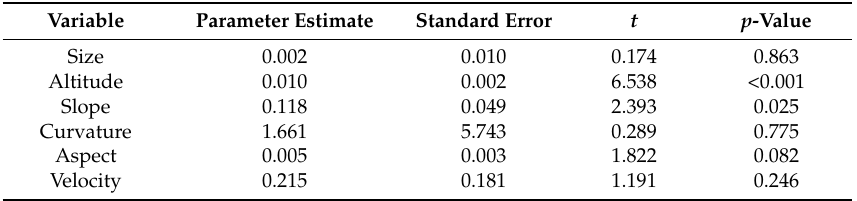
Table 2. Summary of the MLR analysis in the SPSS software package ( T -value ( t ) and p -value are two parameters obtained from the t